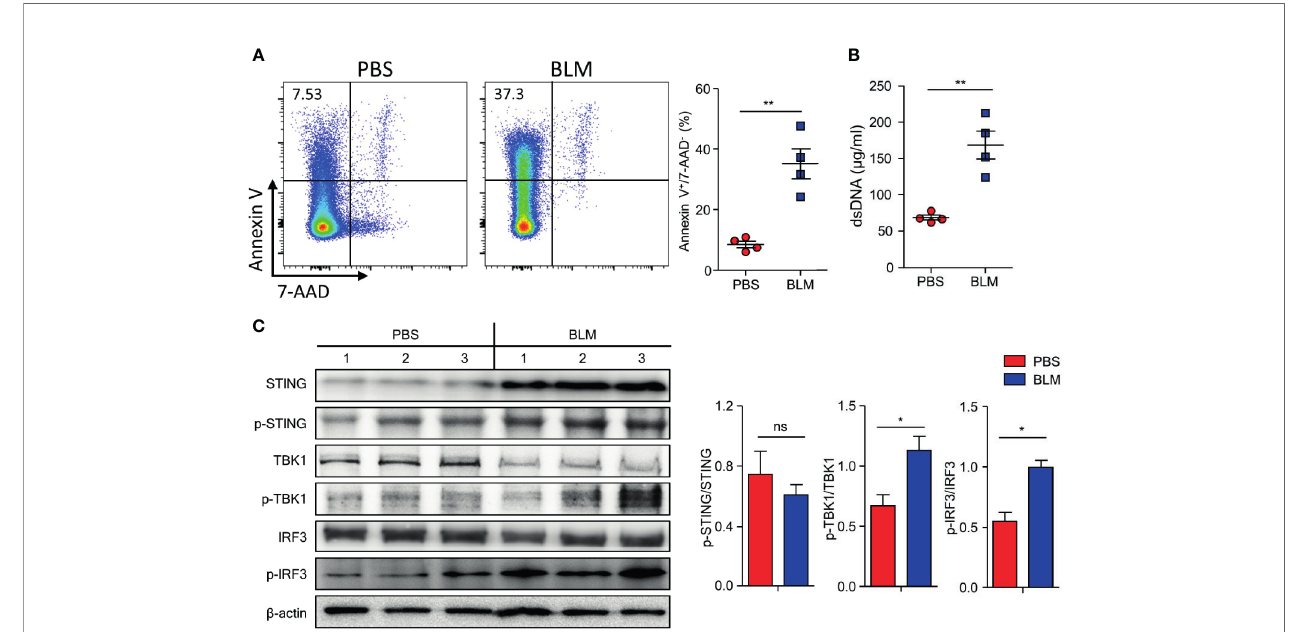
FIGURE 4 | Bleomycin (BLM)-induced lung injury activates cGAS-STING pathway. Mice were administered BLM intranasally, and the lungs were analyzed after 7 days. (A) Apoptotic cells in BALF were measured using FACS ( ■ , n = 4; ■ , n = 4). (B) dsDNA in BALF was quanti fi ed ( ■ , n = 4; ■ , n = 4). (C) Immunoblots of STING, p-STING, TBK1, p-TBK, IRF3, p-IRF3, and b -actin expression in lung homogenates and normalized expression of each of phosphorylated form to its total form indicated (PBS, n = 3; BLM, n = 3). Data are expressed as ±SEM and representative of 1 experiment. Statistical analysis was performed using t-tests